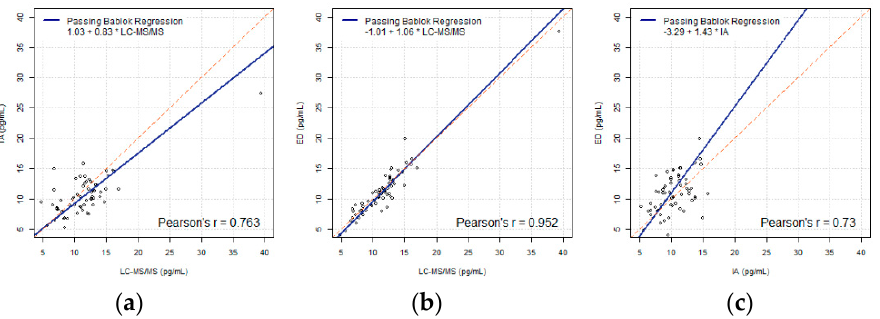
Figure 1. ( A – C ) Passing-Bablok regressions of FT4 (LC-MS/MS, IA, ED) using the FT4 data including outliers ( N = 62), compared pairwise.